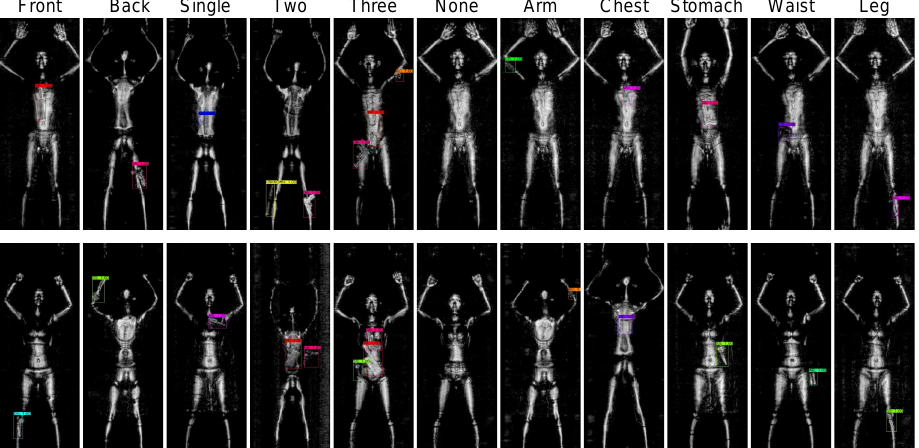
Figure 1. Visualization display of some images with a single object in our terahertz object detection dataset. On the top of the figure are the corresponding class’ abbreviation.